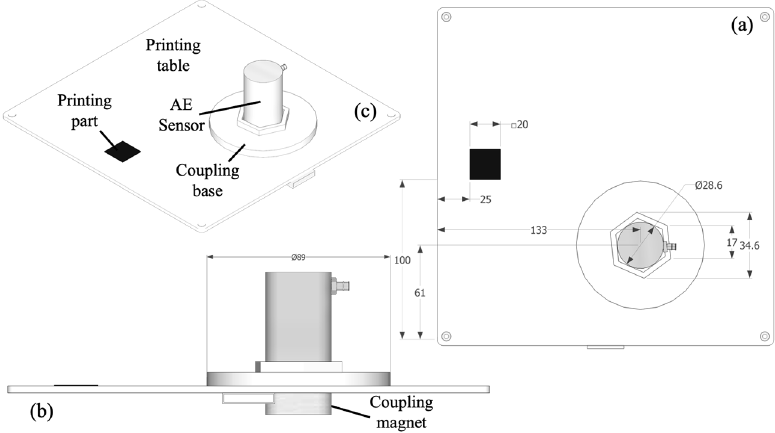
Figure 1. FFF monitoring setup schematic, ( a ) top view, ( b ) front view, ( c ) isometric view.